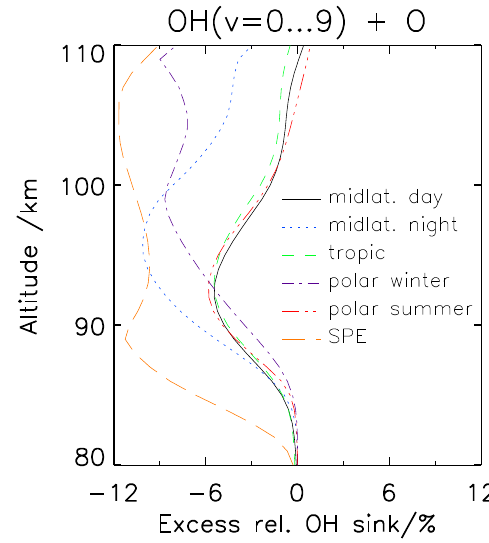
Fig. 13. Excess relative OH sink by consideration of vibrationally excited OH in the OH+O reaction as a function of altitude for vari- ous atmospheres.